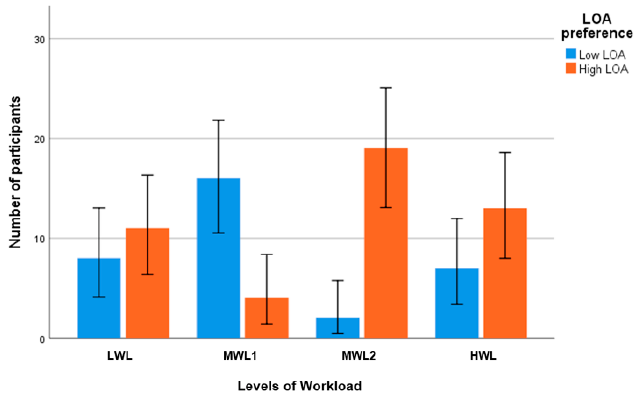
Figure 7. LOA preference for the different workload levels. Table 2. Comparison of assessment (with p -values) within the workload groups *.